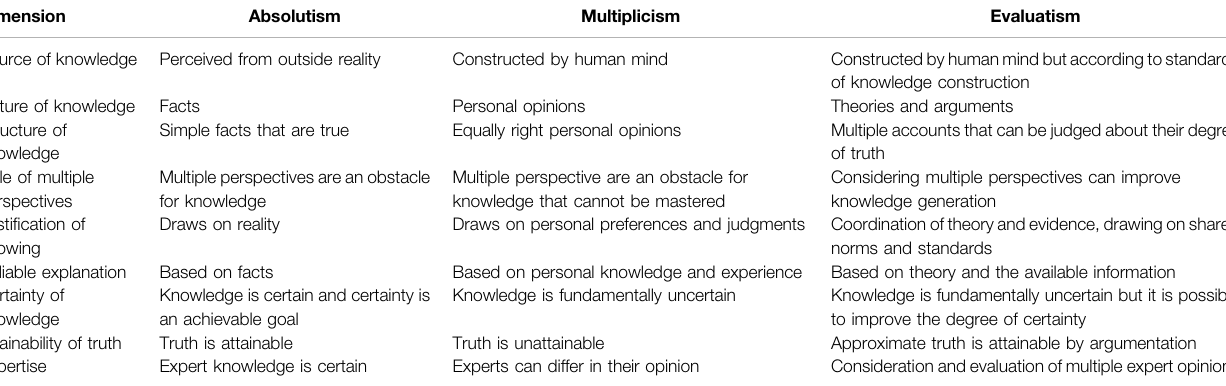
TABLE 1 | Pro fi les of the nine epistemological belief dimensions for each developmental stage [adapted from Barzilai and Weinstock (2015)].